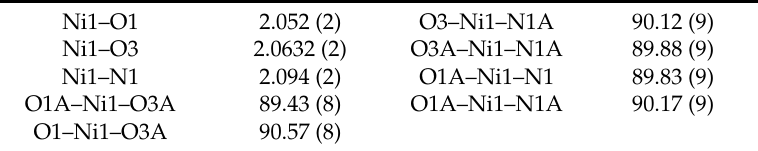
Table 2. Selected bond lengths (Å) and angles (°) for 1 .